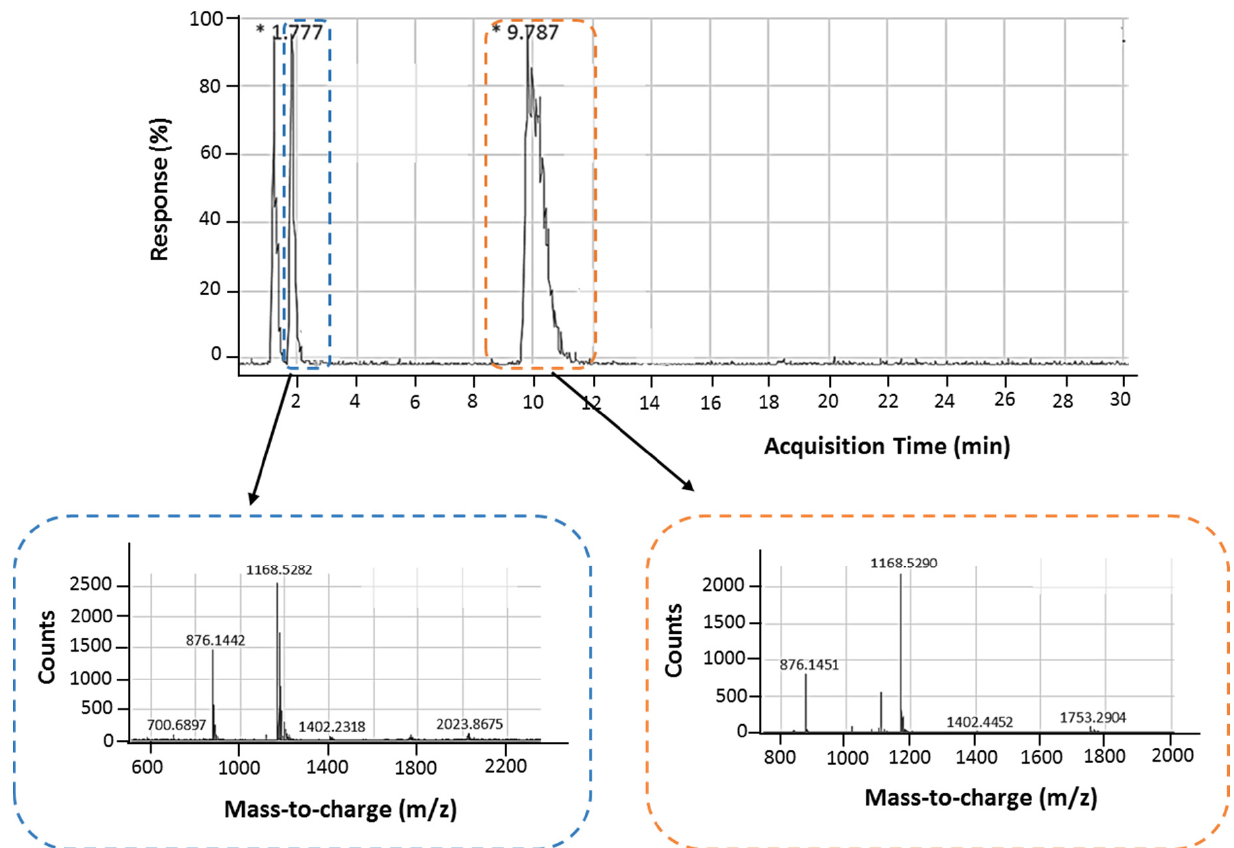
Figure 2. HPLC-ESI-TOF-MS analysis of the 11-mer. The top panel is the chromatogram showing the HLPC separation of the monomeric and multimeric structures, and the bottom panels show the MS for each peak obtained in HPLC.